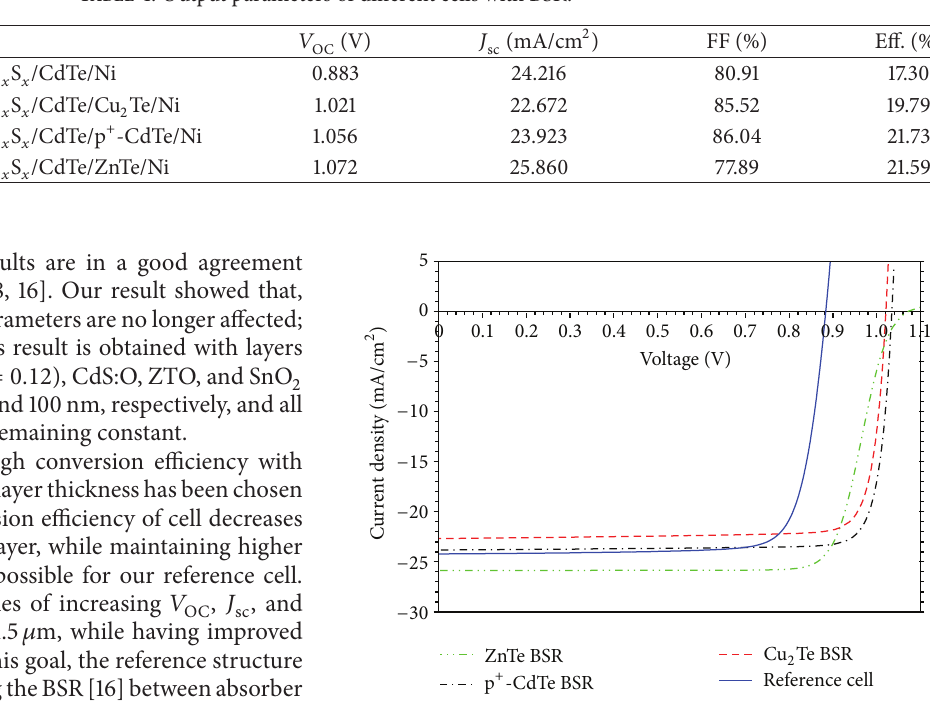
Figure 4: Effect of CdTe thickness on FF, 𝑉 OC , 𝐽 sc , and efficiency of solar cell. Table 4: Output parameters of different cells with BSR.